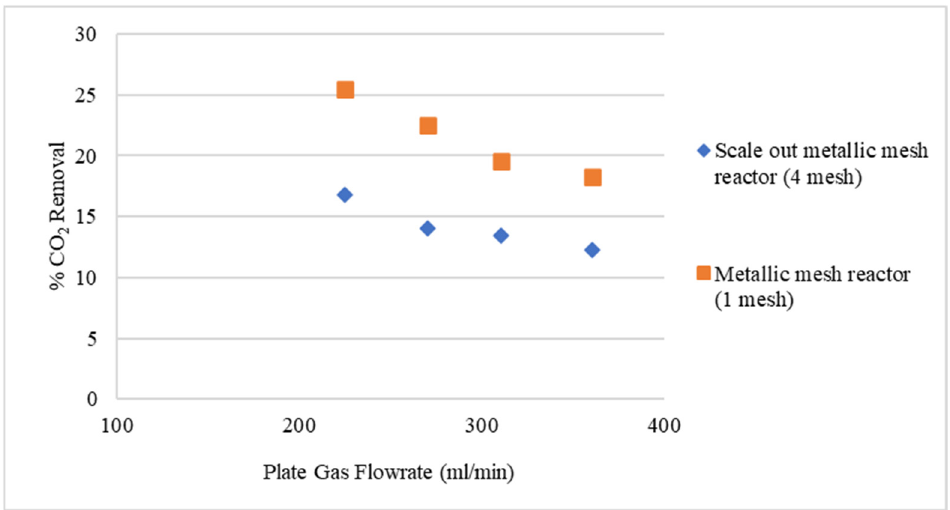
Figure 9. Comparison between the scale out and metallic mesh reactors (1 ‐ mesh and 4 ‐ mesh) for CO 2 absorption in 2 M NaOH solution. δ G = 850 μ m, δ L = 200 μ m, Y CO2 /Y NaOH = 139.5, mesh porosity CO 2 absorption in 2 M NaOH solution. δ G = 850 µ m, δ L = 200 µ m, Y CO2 / Y NaOH = 139.5, mesh 15%. porosity